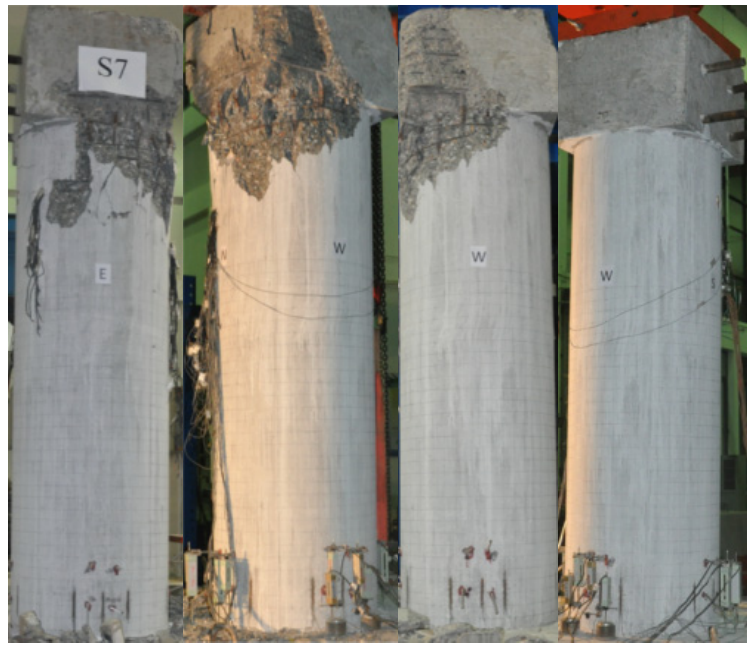
Figure 9. Top pier concrete spalling area of specimen S7.